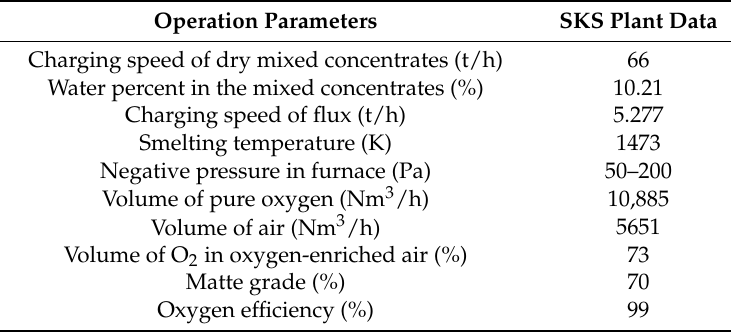
Table 2. Industrial operation parameters in SKS (Shuikoushan)